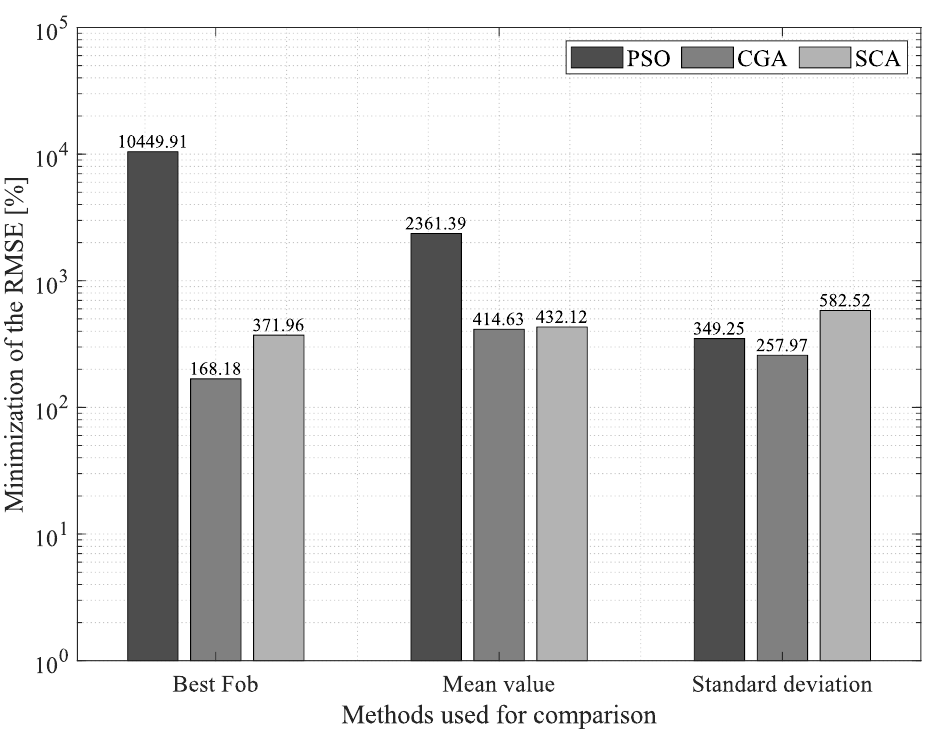
Figure 10. Robustness of the proposed solution methodologies in solving the parameter estimation problem of the TDM of the KC 200 GT .